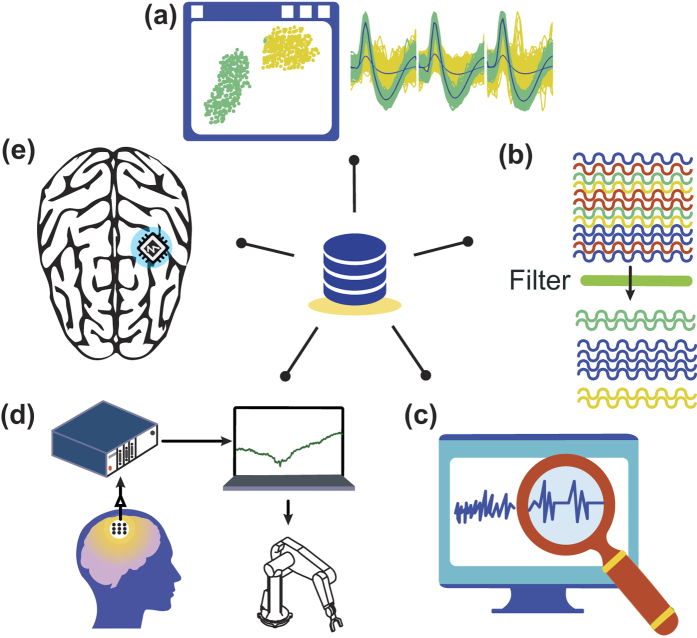
Examples of bio-inspired neural benchmark applications.Such benchmarks are needed in two contexts, on the one hand, in applications that involve fine signal processing usually executed on computers such as (a) neural pattern detection, (b) cluster classification algorithms and (c) signal denoising methods, and on the other hand in applications with direct exploitation of signals, usually executed on electronic devices, such as (d) brain-computer interfaces and (e) on-site decoding neural prosthetics.